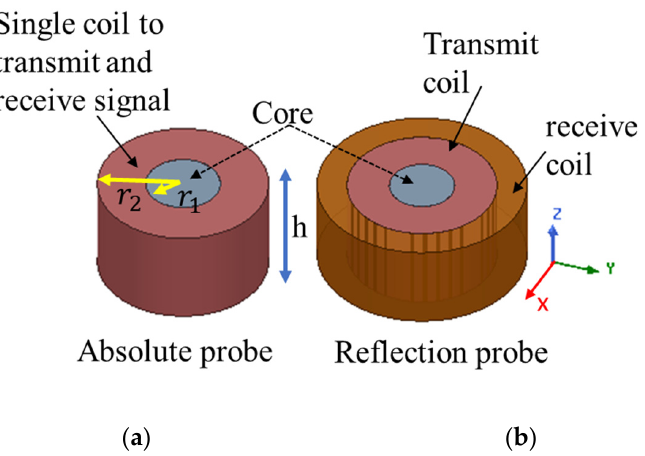
Figure 2. Absolute and reflection probe geometry differences; ( a ) shows an absolute probe that has only one coil, ( b ) shows a reflection probe that has two coils.